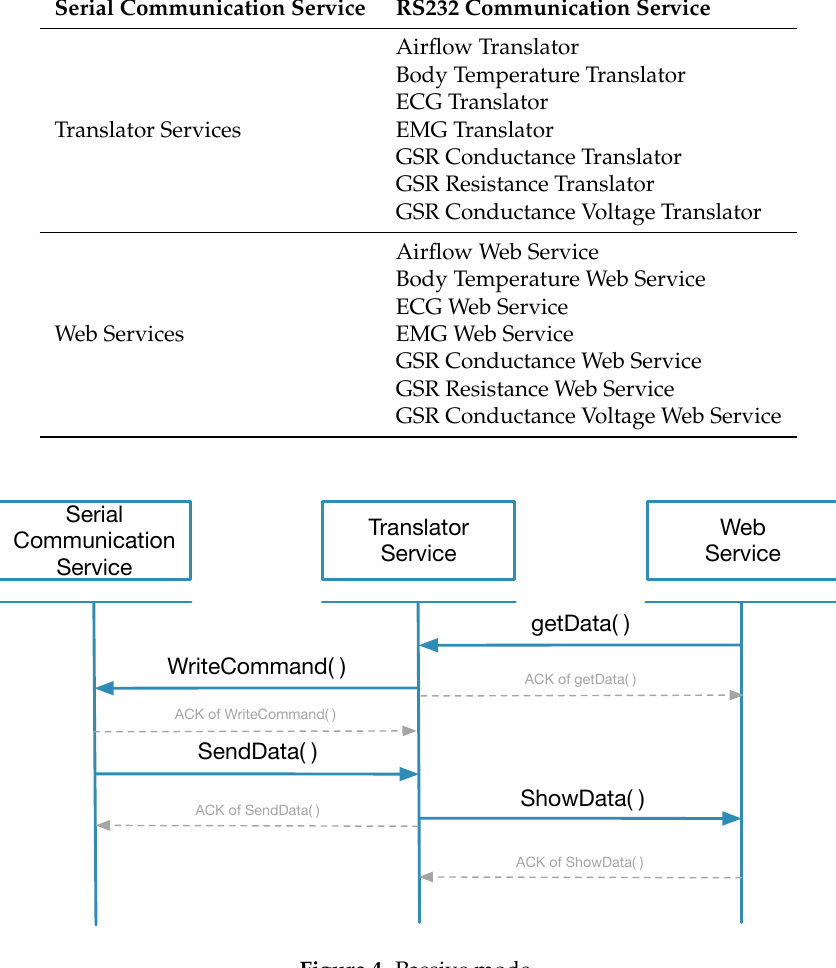
Figure 4. Passive